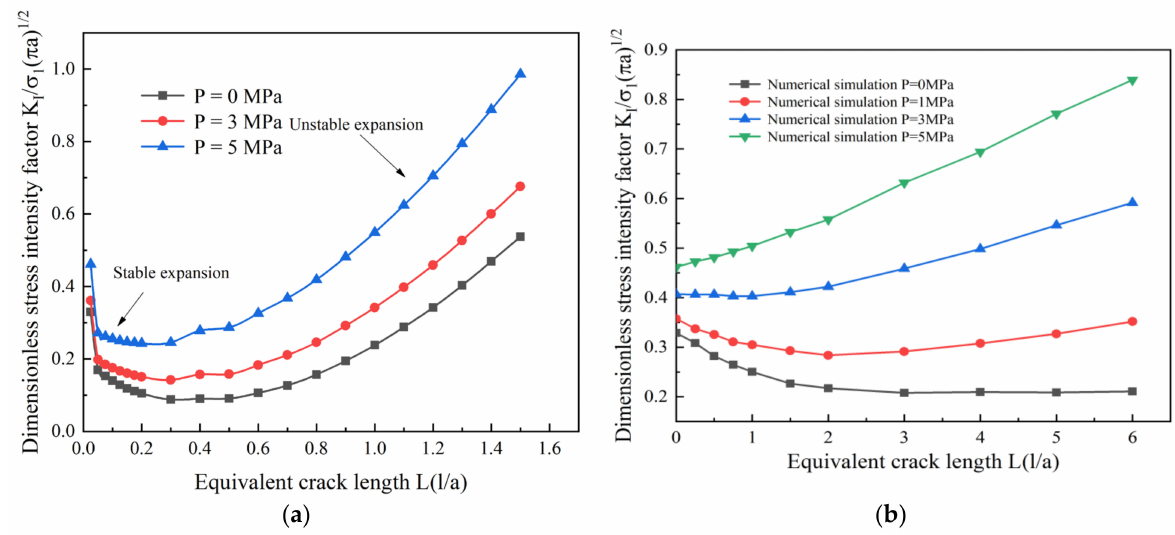
Figure 7. The relationship curves between dimensional stress intensity factor at the crack tip wing stress and crack propagation length under different hydraulic pressures. ( a ) Theoretical data; ( b ) ANSYS numerical simulation data